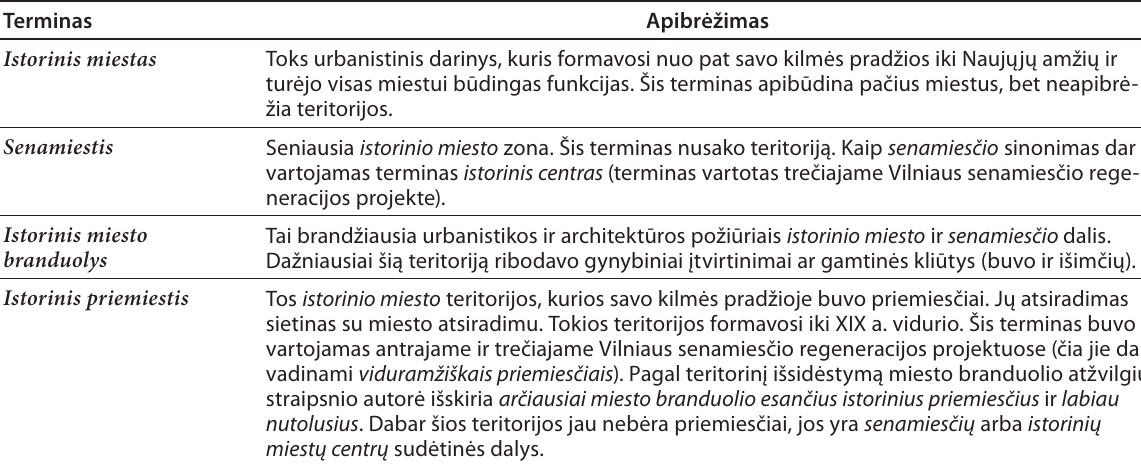
Table 1. Concepts used in the paper Terminas